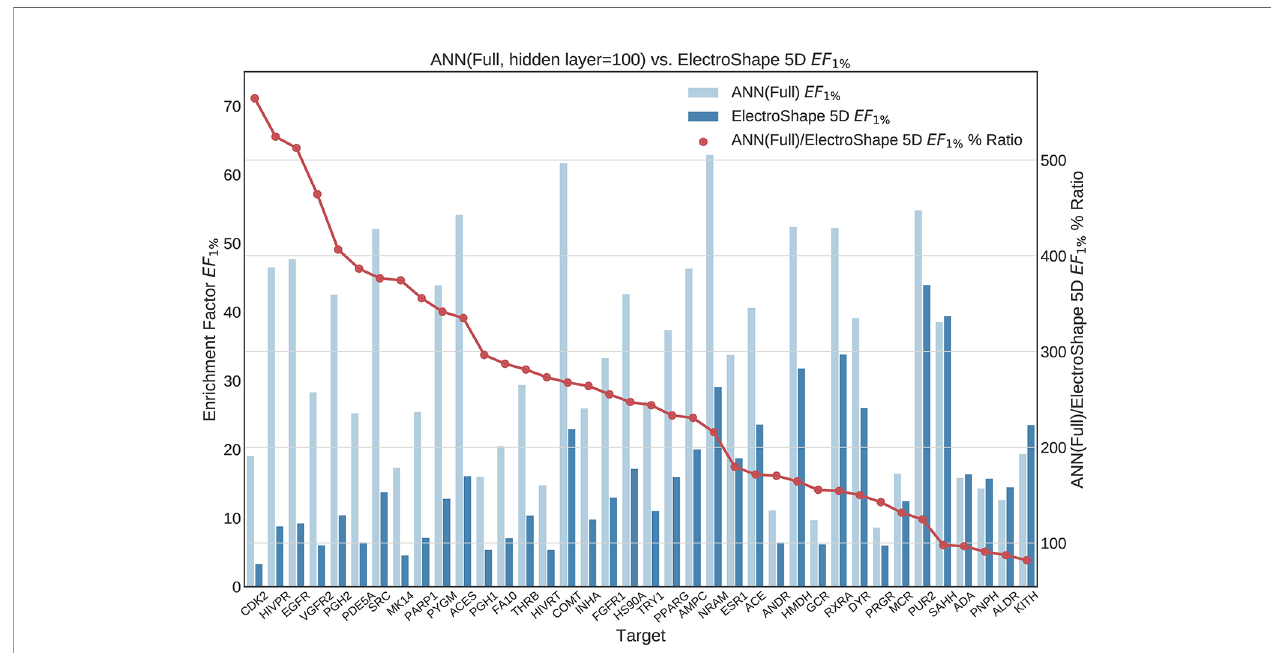
FIGURE 10 | Comparison of Enrichment Factor at 1% obtained by Arti fi cial Neural Networks with 100-node hidden layer with that obtained by ElectroShape 5D using full conformer models. Also plotted is the percentage ratio of the Enrichment Factor score of Arti fi cial Neural Network (ANN) compared to ElectroShape 5D. Mean ratio = 256% ± 129%, max = 565%, min = 82%.